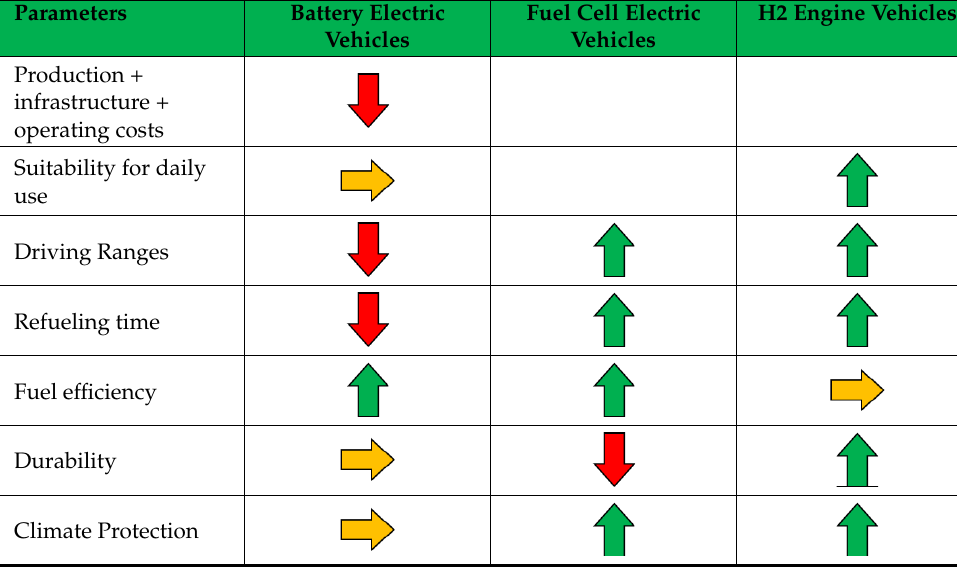
Table 1. Comparison of the three zero-emission technologies.